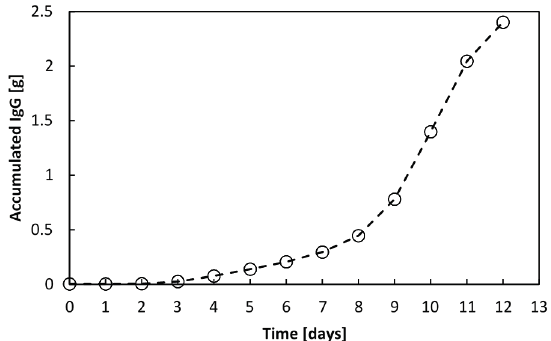
Figure 14. Accumulated recombinant IgG 1 manufactured by an encapsulated cell perfusion culture. After 12 days, 2.4 g of IgG 1 was produced by 14.5 × 10 6 v cells·mL − 1 WV in a 1.4 L